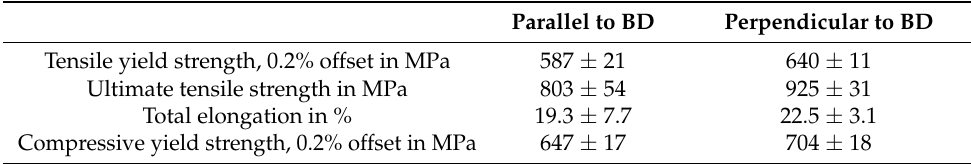
Table 2. Mechanical properties of LPBF samples oriented parallel or perpendicular to build direc- tion (BD).